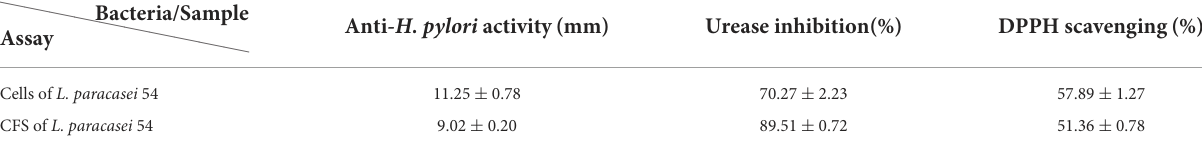
TABLE 3 Anti- H. pylori activity, urease inhibition, and DPPH scavenging of L. paracasei 54. `````````` Bacteria/Sample Assay